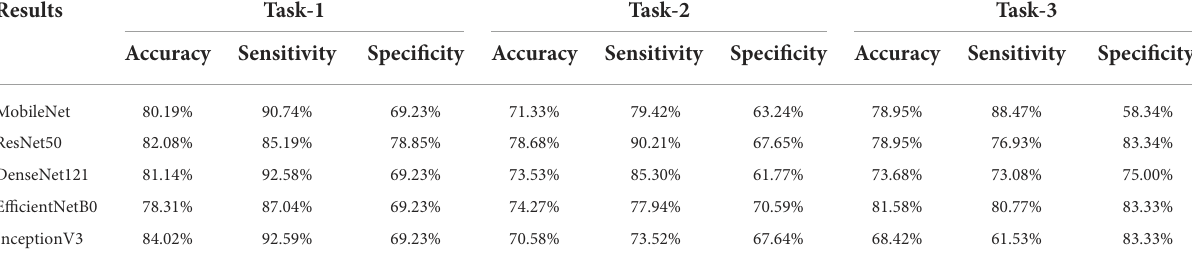
TABLE 3 Five models’ prediction results of three tasks at the patient